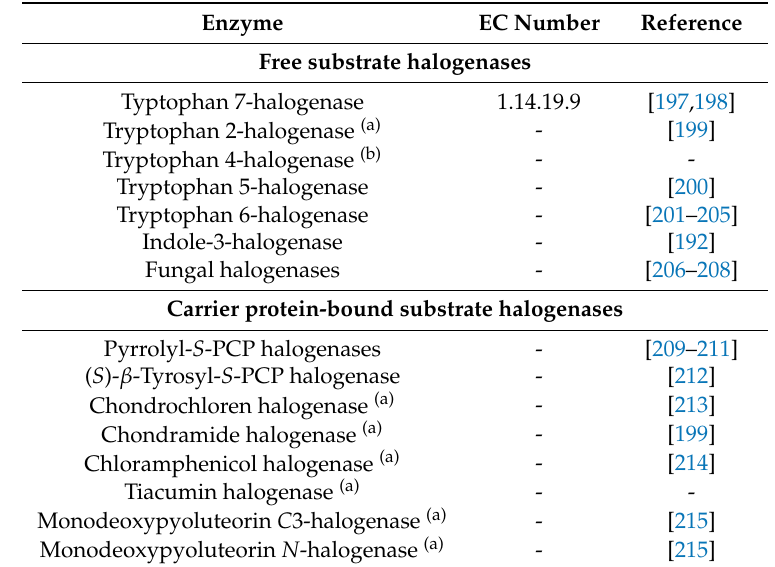
Table 4. Representatives of Group F.